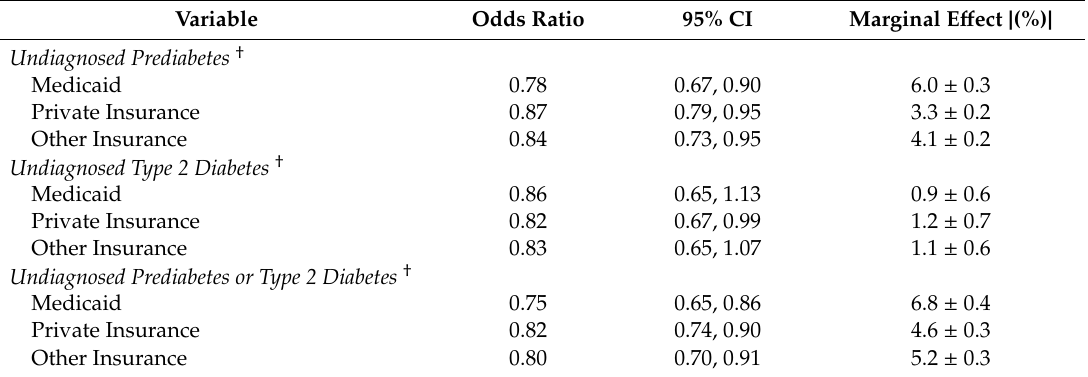
Table 2. Associations of health insurance type and undiagnosed prediabetes and type 2 diabetes.